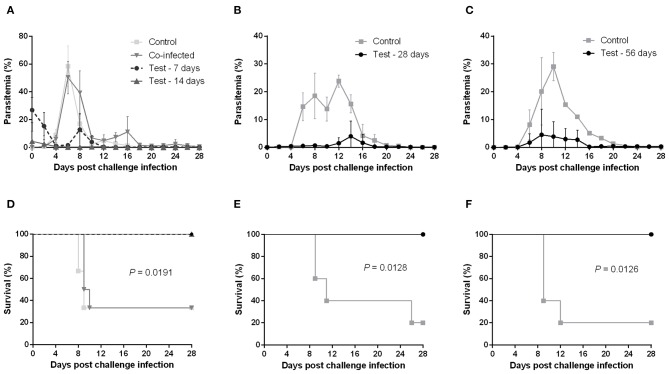
Course of P. chabaudi challenge infection in BALB/c mice undergoing different stages of primary B. microti infection. Test BALB/c mice were initially infected with B. microti and then challenge-infected with P. chabaudi at different time points (on days 0, 7, 14, 28, or 56) post primary infection. Control mice received P. chabaudi alone. Courses of parasitemia (A–C) and survival rates (D–F) of control and test mice are presented. Results are expressed as mean percent parasitemia values ± the standard deviation (SD) of five or six mice. Mean percent parasitemia values are calculated from individual percent parasitemia levels taken from all surviving mice at each specific time point. Experiment shown is representative of three independent experiments. Experiments of challenge infection on days 0, 7, and 14 (A,D) belonged to a single cohort and as such share the same control group.